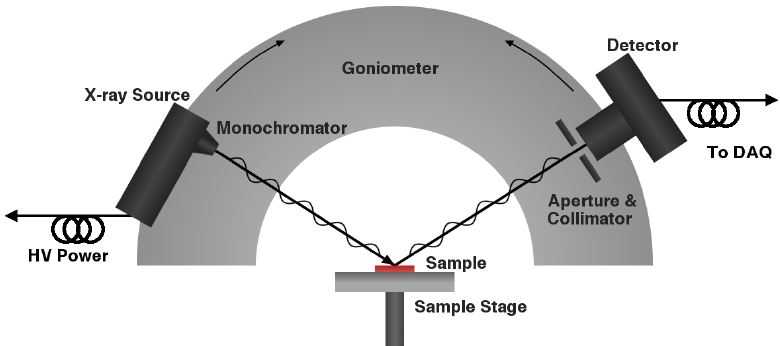
Figure 4. The X-ray source and detector are attached to a goniometer that allows for consistent, relative rotation with respect to the sample surface so that the detector may always be positioned such that only the specularly-reflected beam is considered. The XRR often incorporates a monochromator, entrance aperture and collimator to improve the reliability of the